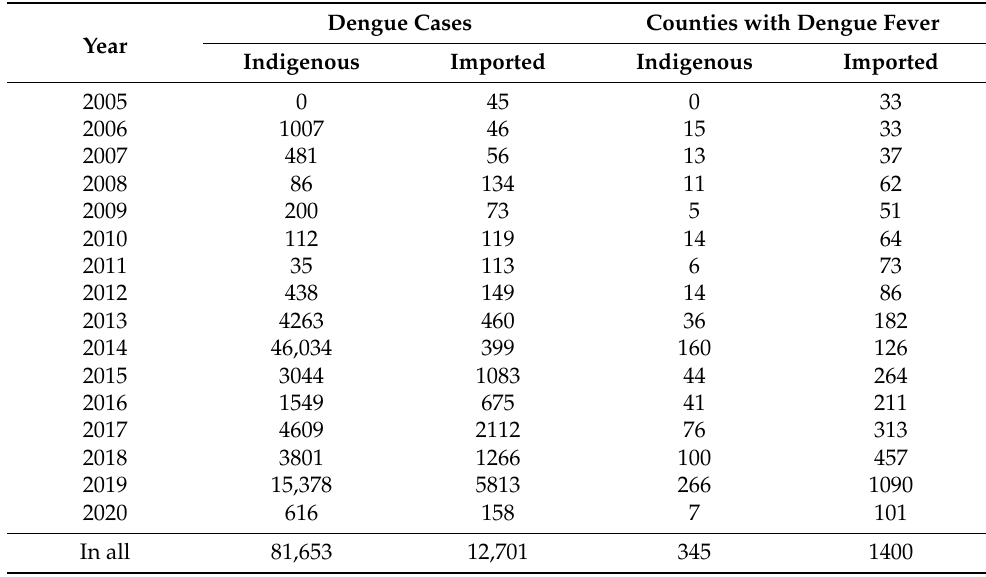
Figure 1. Spatial distribution of dengue fever in mainland China during 2005–2020. ( A ) Indigenous cases. ( B ) Indigenous incidence rate. ( C ) Imported cases. Table 1. Comparison of indigenous and imported dengue cases in mainland China,